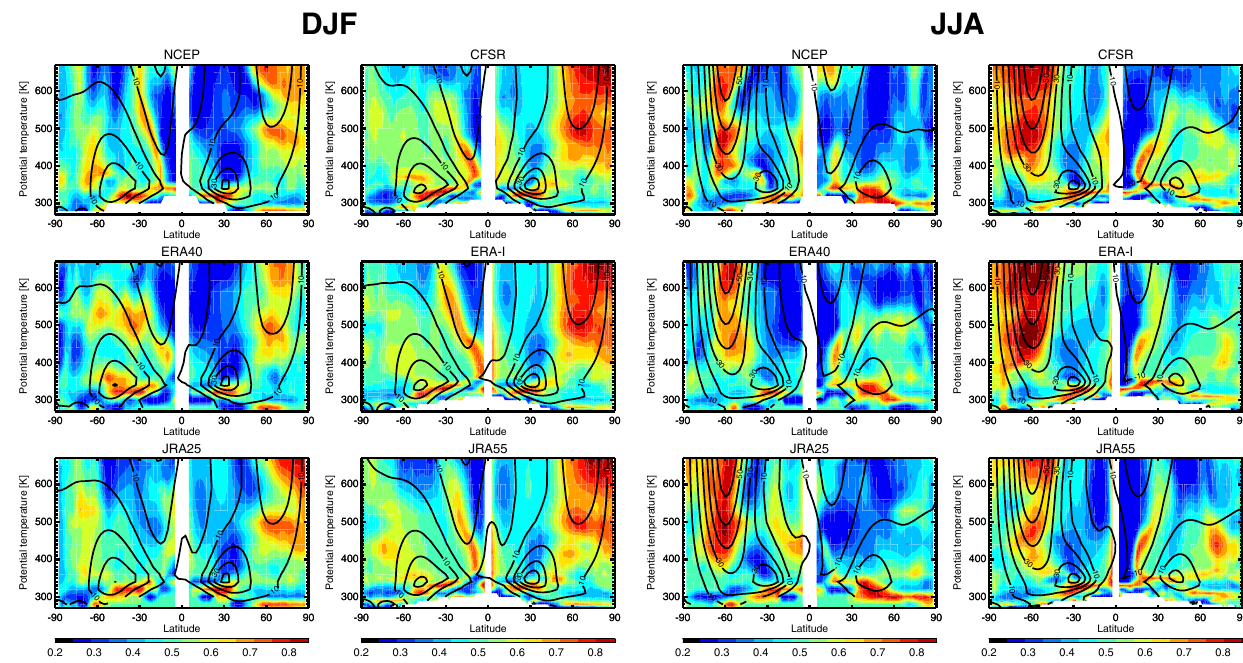
Figure 8. Same as Fig. 1 but for the relative importance of the eddy transport to the total meridional transport. The value larger (smaller) than 0.5 indicates that the eddy transport (mean transport) is dominant in the meridional